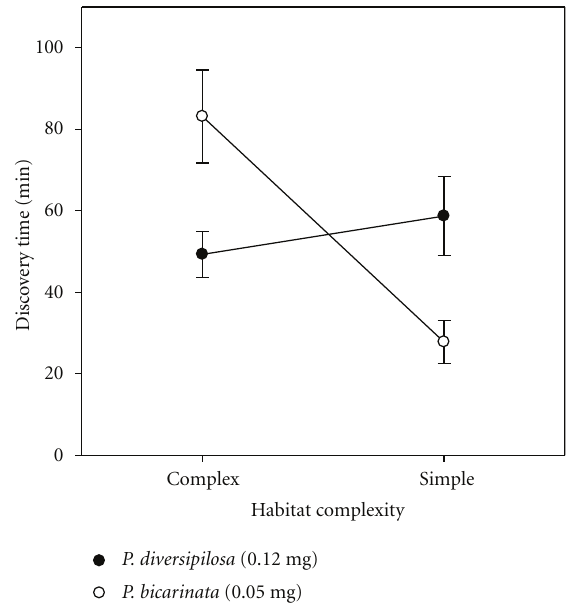
Figure 1: Di ff erences in resource discovery time between P. diver- sipilosa and P. bicarinata in complex and simple habitats. Means and standard errors are